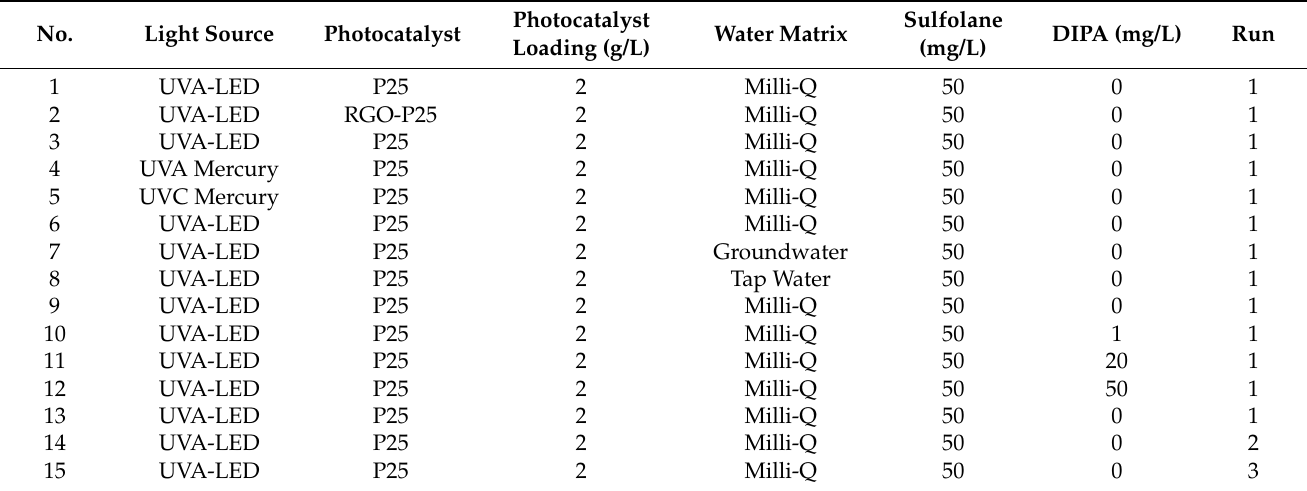
Table 4. Details of photocatalytic degradation